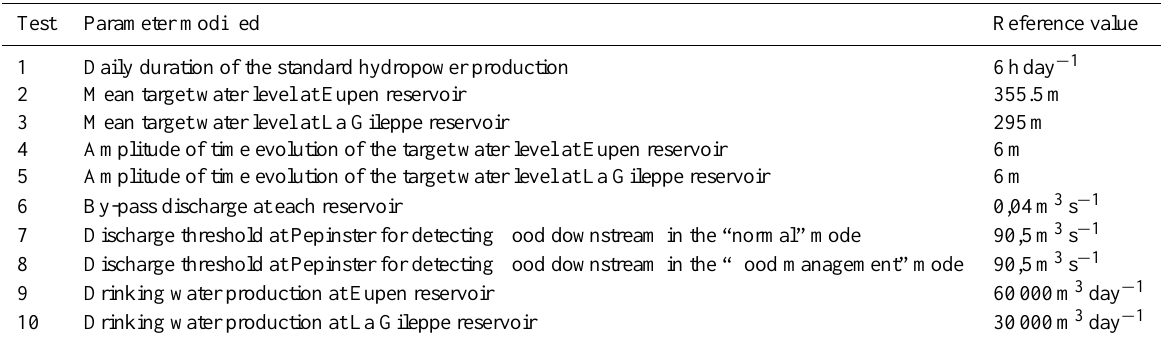
Table 5. Main parameters of the operation rules.